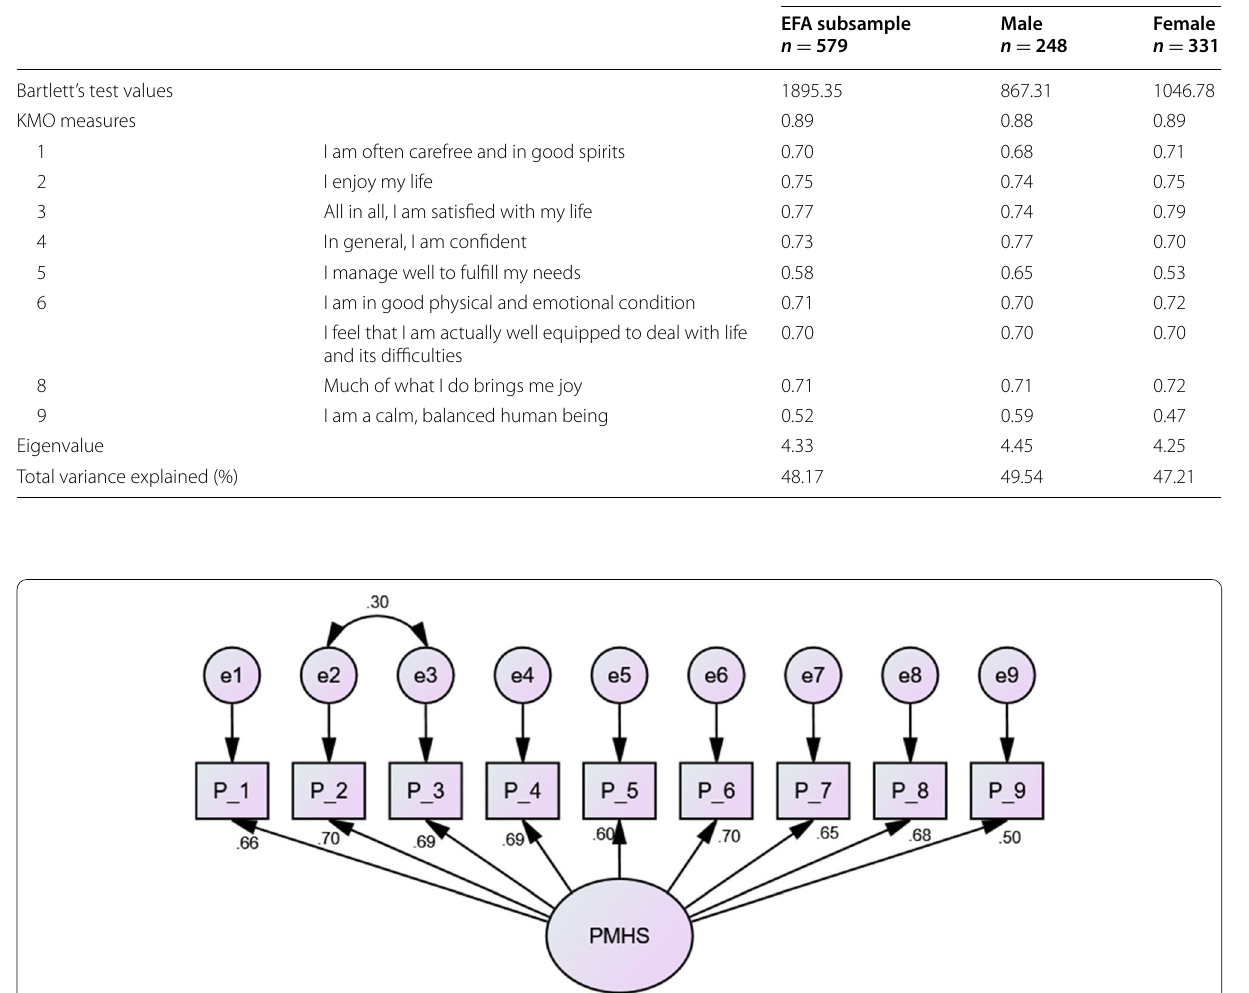
Fig. 1 Confirmatory factor analysis model for the second subsample data, including standard loadings and standardized errors. n confirmatory factor analysis (CFA) model of the Positive Mental Health (PMH)